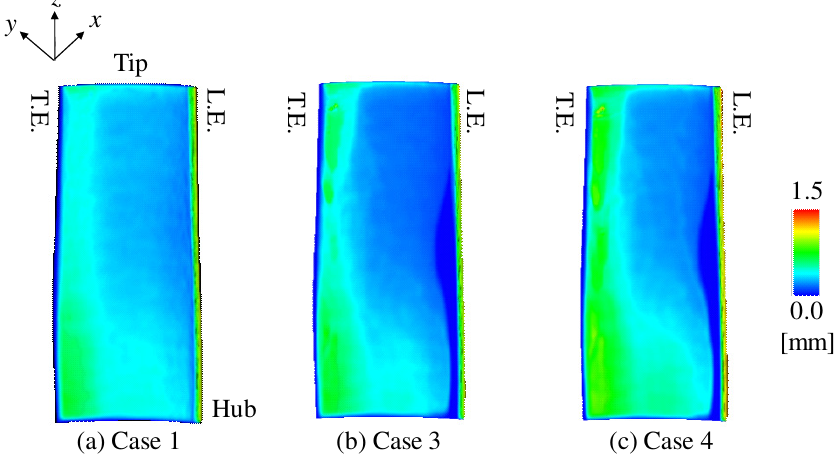
Figure 5. Ice thickness distribution on the pressure surface: ( a ) Case 1, ( b ) Case 3, and ( c ) Case 4.